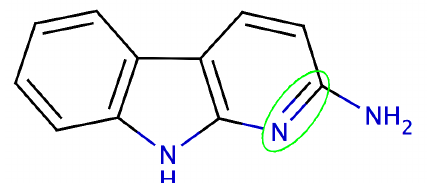
Figure 2: An Example Pattern from a Small Organic Molecule: